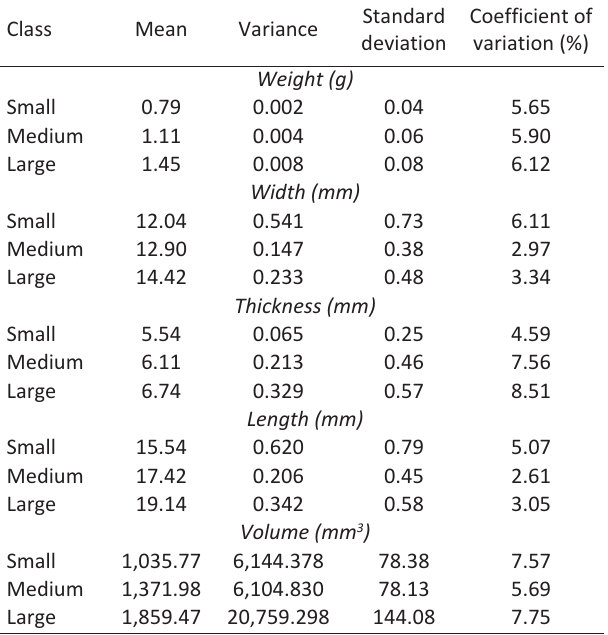
Table 1 - Biometric characteristics of camu-camu seeds from native populations in the State of Roraima, classified by size